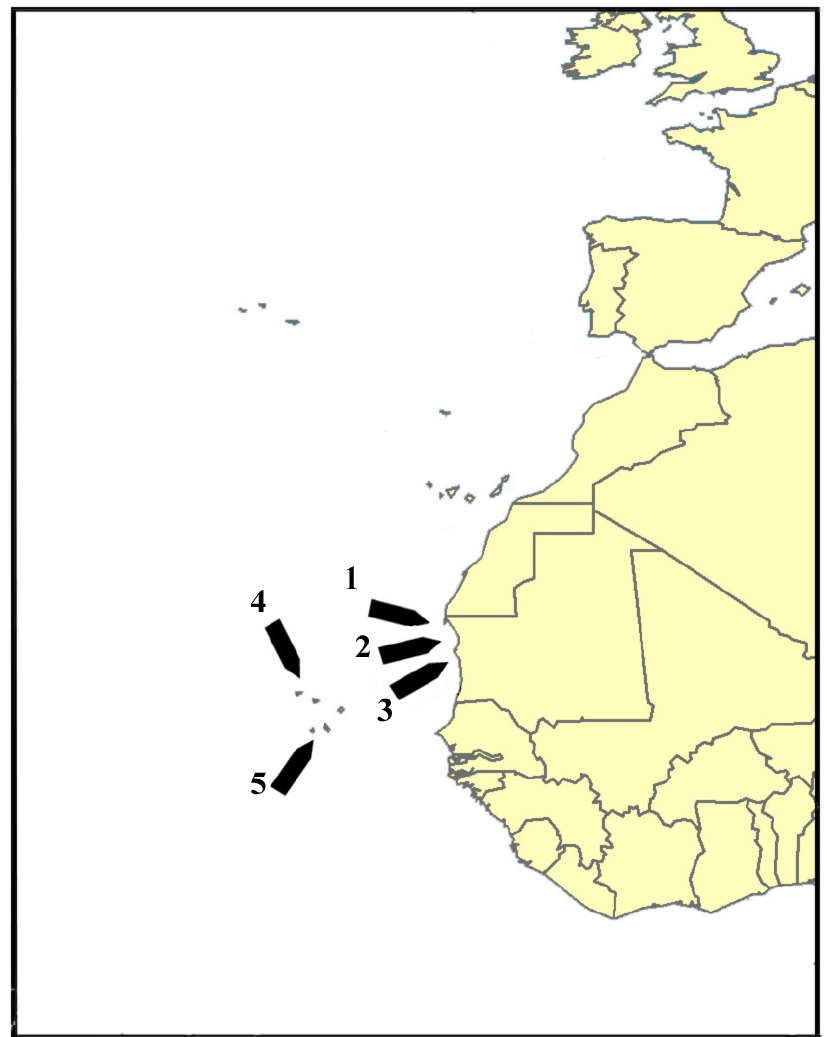
Fig. 1. Map of Northwest Africa, showing the approximate localities from which the sponges were collected. 1 . Mauritania, Cap Blanc. 2 . Mauritania, Banc d’Arguin. 3 . Mauritania, SW of Cap Timiris 4 . Cape Verde Islands, São Vicente 5 . Cape Verde Islands, Ilheu de